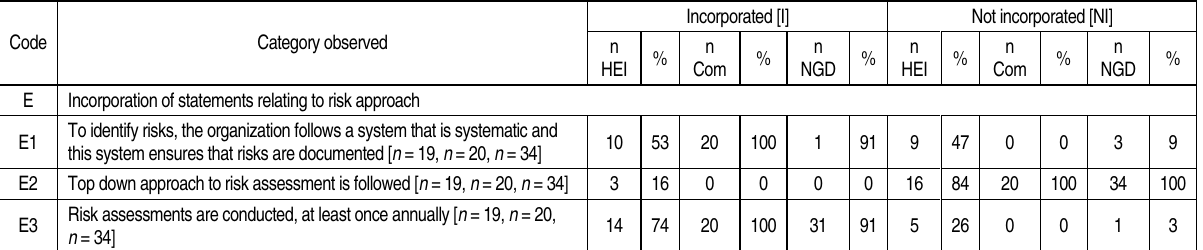
Table 2. Incorporation of statement relating to risk approach, risk response and management responsibility,